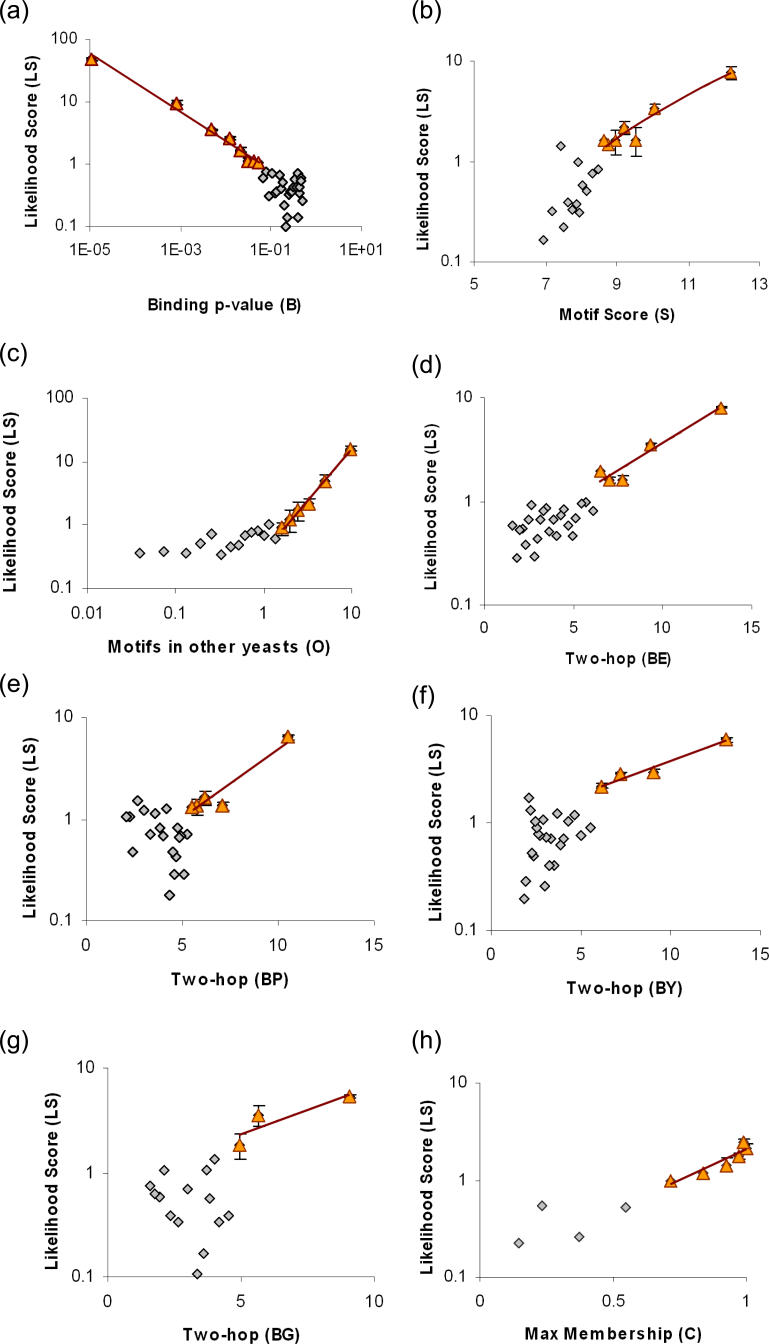
Regression Lines Used for Scaling the Different Evidence Types Needed for Predicting TF–Target InteractionsTF–target pairs were binned according to the value of the respective evidence type, and the LS for each bin was calculated using the validation sets (Equation 1). Each point is the average of five runs with different negative validation sets (the positive set was always the same). Error bars represent standard deviations over the validation sets. Gray diamonds lie in parameter ranges that were excluded from the LS prediction because the LSs were not significant. Abbreviations used in the x-axis labels are explained in the main text.